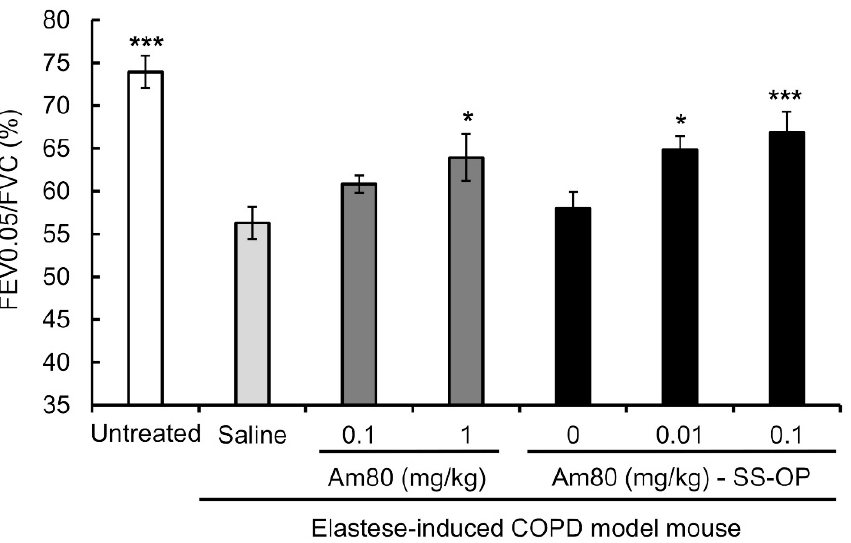
Figure 5. The respiratory-function-improving effect of free Am80 or Am80-encapsulated SS-OP nanoparticles in the elastase-induced COPD model mouse. FEV0.05/FVC was measured by flexiVent. Data represent the mean ± S.E. (n = 3–6). * p < 0.05 and *** p < 0.001, Dunnett’s test, vs. saline group.